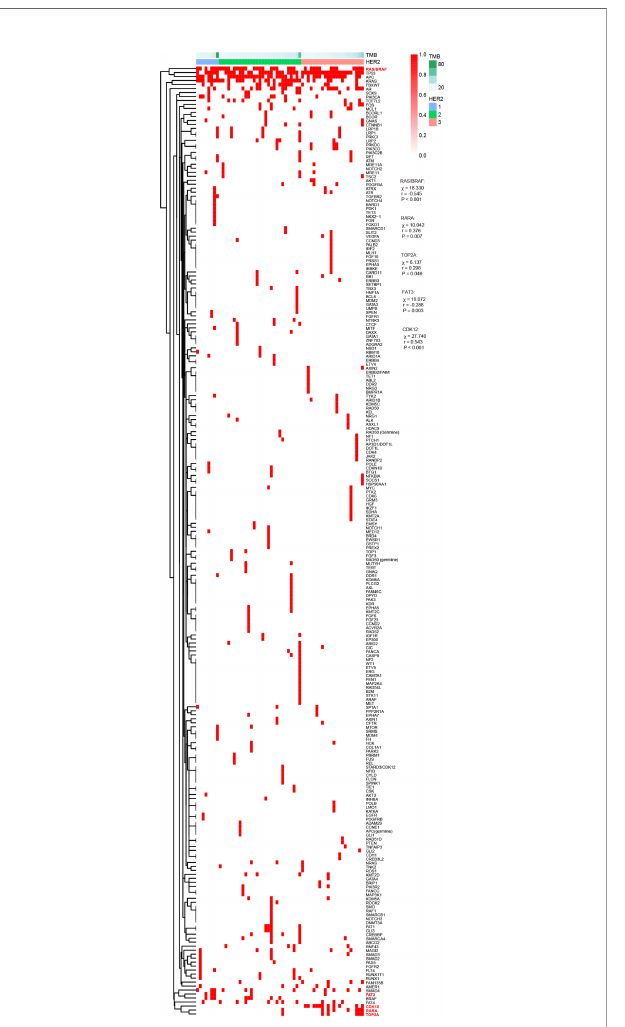
FIGURE 4 | Association of HER2 expression with TMB and gene mutation according to different criteria. HER2, human epidermal growth factor receptor 2; TMB, tumor mutational